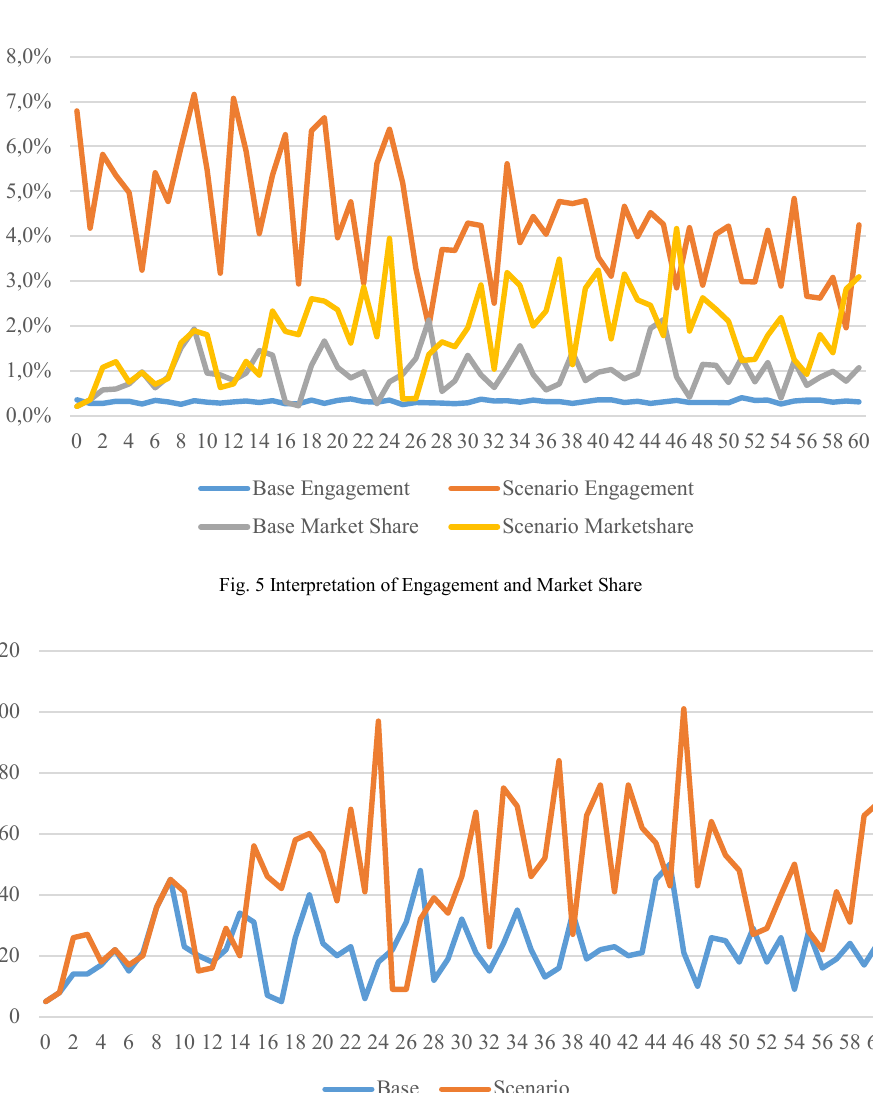
Fig. 6 Interpretation of Company Total